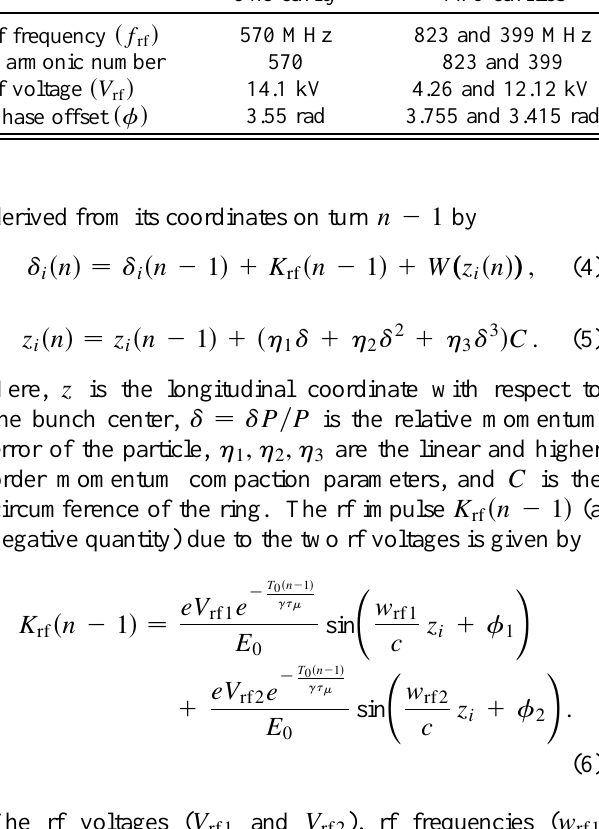
FIG. 1. The longitudinal beam phase space at (a) turn 1 and (b) turn 1000 when the rf voltages are not applied. The beam distribution after 1000 turns is distorted by the bunch wake. The initial energy spread was s d (cid:173) (cid:49) 3 (cid:49)(cid:48) 2 (cid:51) , h (cid:49)